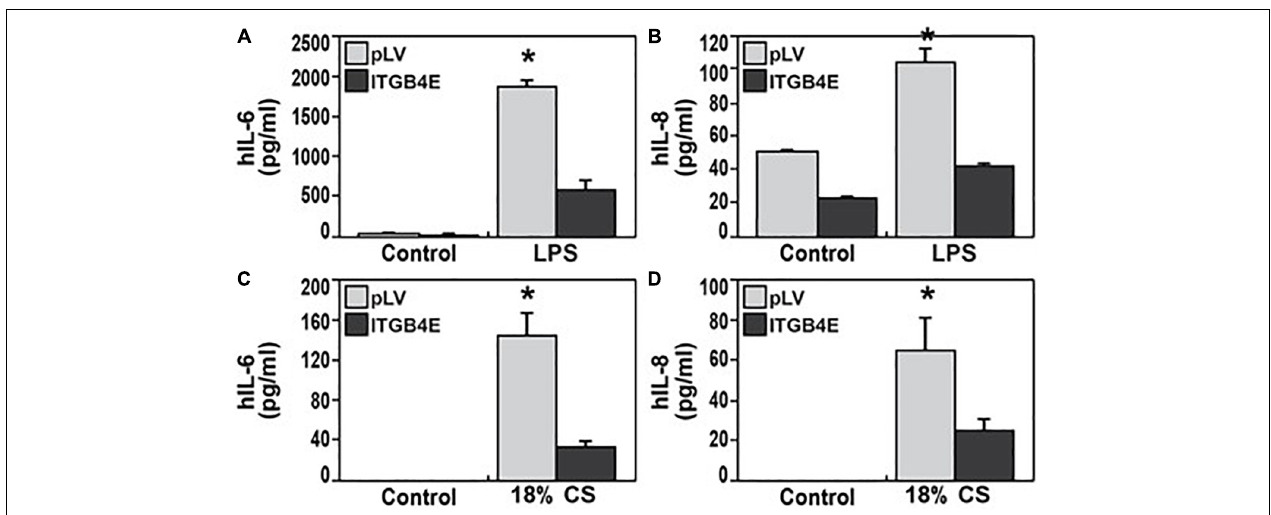
FIGURE 6 | Reduced EC inflammatory responses associated with ITGB4E overexpression. Human pulmonary artery ECs were transfected with ITGB4E or control vector and then subjected to inflammatory stimuli, either LPS 100 ng/ml (4 h) or excessive cyclic stretch (CS, 18% elongation, 4 h). Media were then collected and used for measurements of inflammatory cytokines, human IL-6, and IL-8 [ (A,B) , respectively, after LPS; (C,D) , respectively, after CS] ( n = 3 independent experiments, * p < 0.05 compared with respective controls).